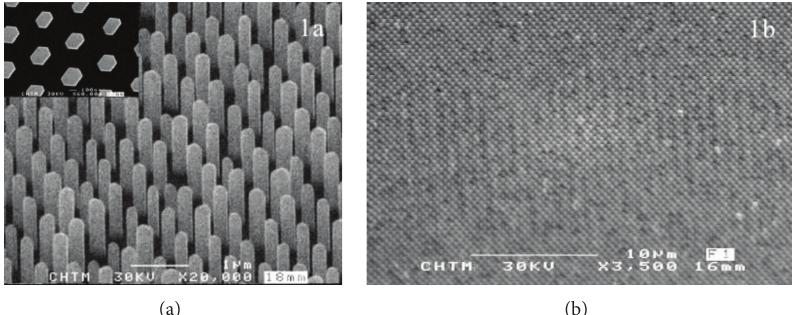
Figure 3: (a) High magnification SEM image (inset shows plan view) and (b) lower magnification SEM image of a GaN nanowire array. Reprinted with permission from [15]. Copyright 2006 American Chemical